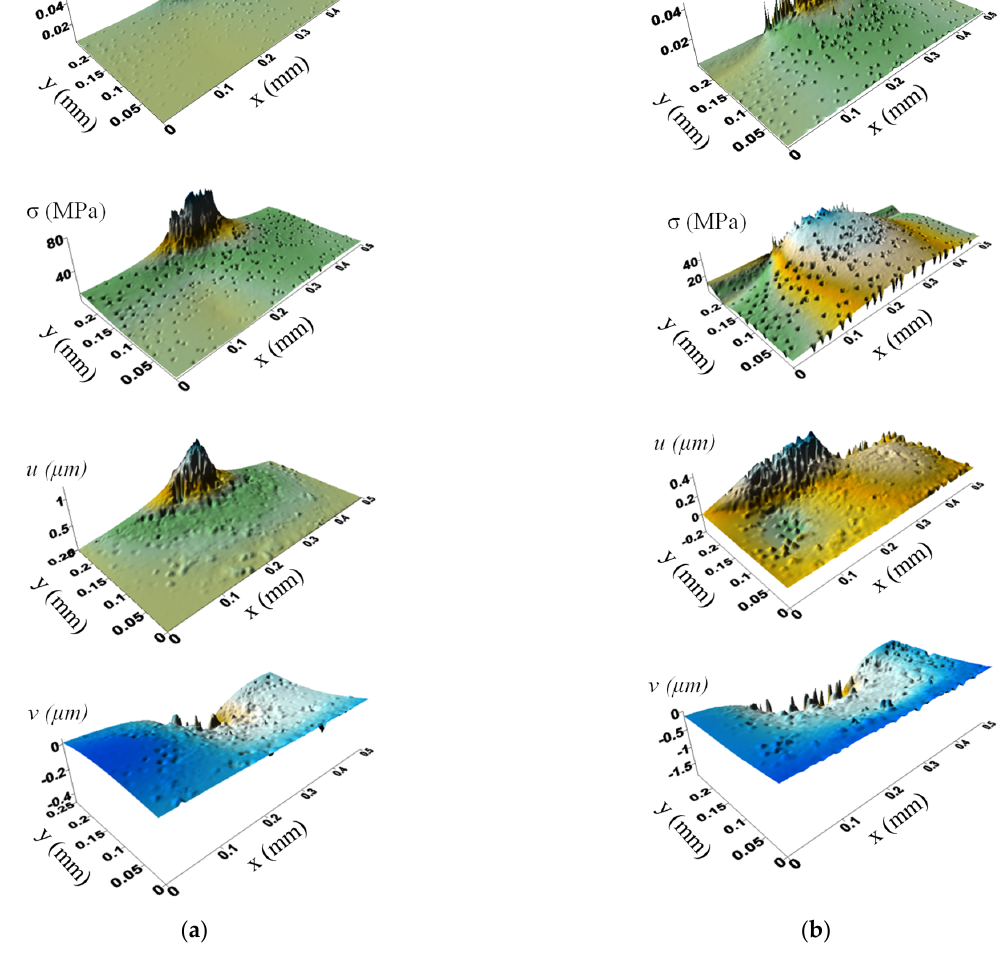
Figure 18. The surfaces of strains and stress intensities as well as displacements along the X (u) and Y (v) axis; pores are taken into account; the counterpart roughness of 0.1 μ m ( a ) 1 μ m ( b ).